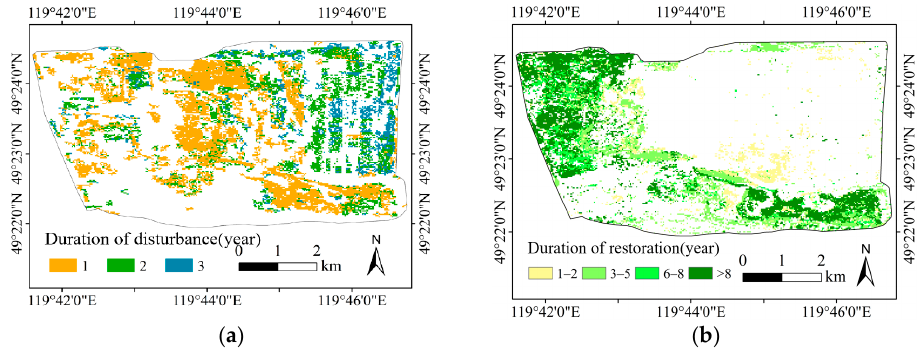
Figure 10. Duration of vegetation disturbance and restoration. ( a ) Duration of disturbance; ( b ) Duration of restoration.